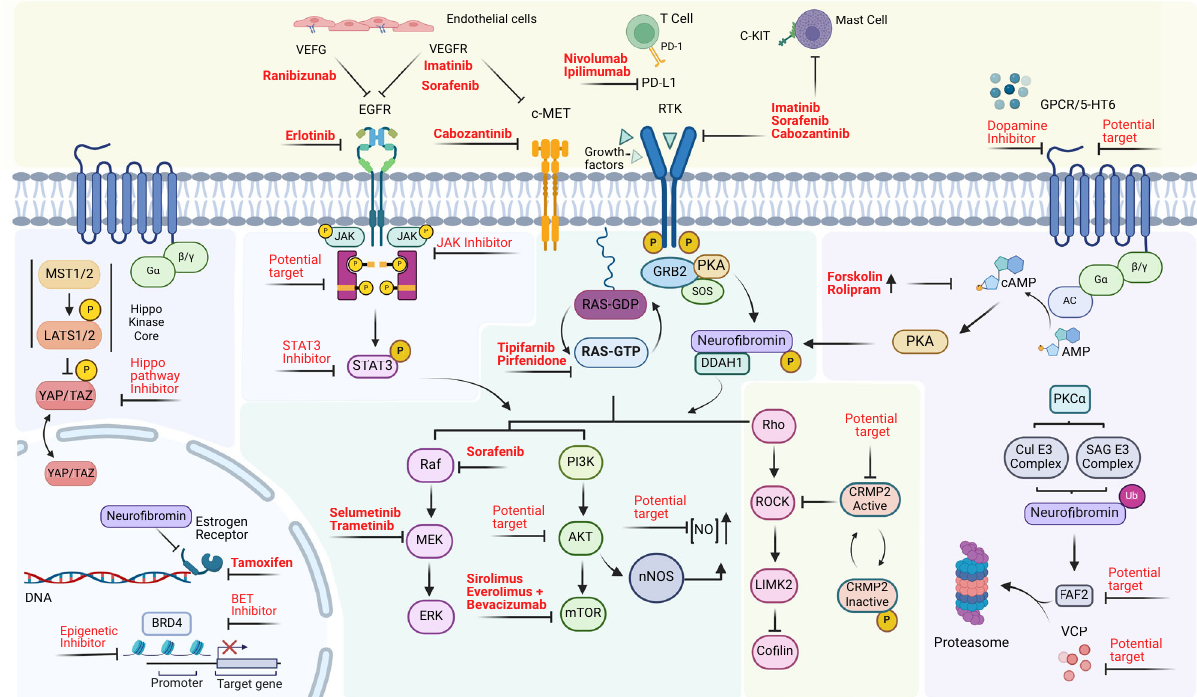
Fig. 5 Neuro fi bromin therapeutic inhibitors and potential targets. The identi fi cation of key regulatory neuro fi bromin partners may have important clinical implications, in a strategy aimed at blocking its inactivation and/or upregulating the protein. These bene fi ts may extend beyond therapies relevant to neuro fi bromin to serve as a potential clinical strategy to attenuate the Ras pathway in tumors harboring variants in genes that function upstream of Ras. Inhibitors and potential targets are shown in